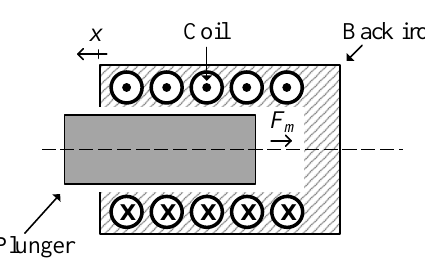
Figure 10. Schematic figure of the solenoid actuator consisting of plunger, coil and back-iron. The reluctance force generated in the actuator is denoted by F m .